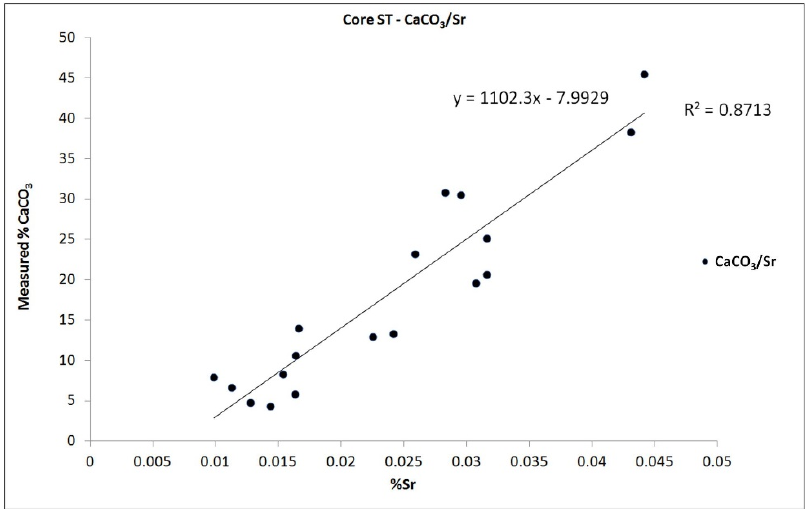
Figure 5. Calibration chart for measured carbonate content and strontium values from XRF analysis for core ST.